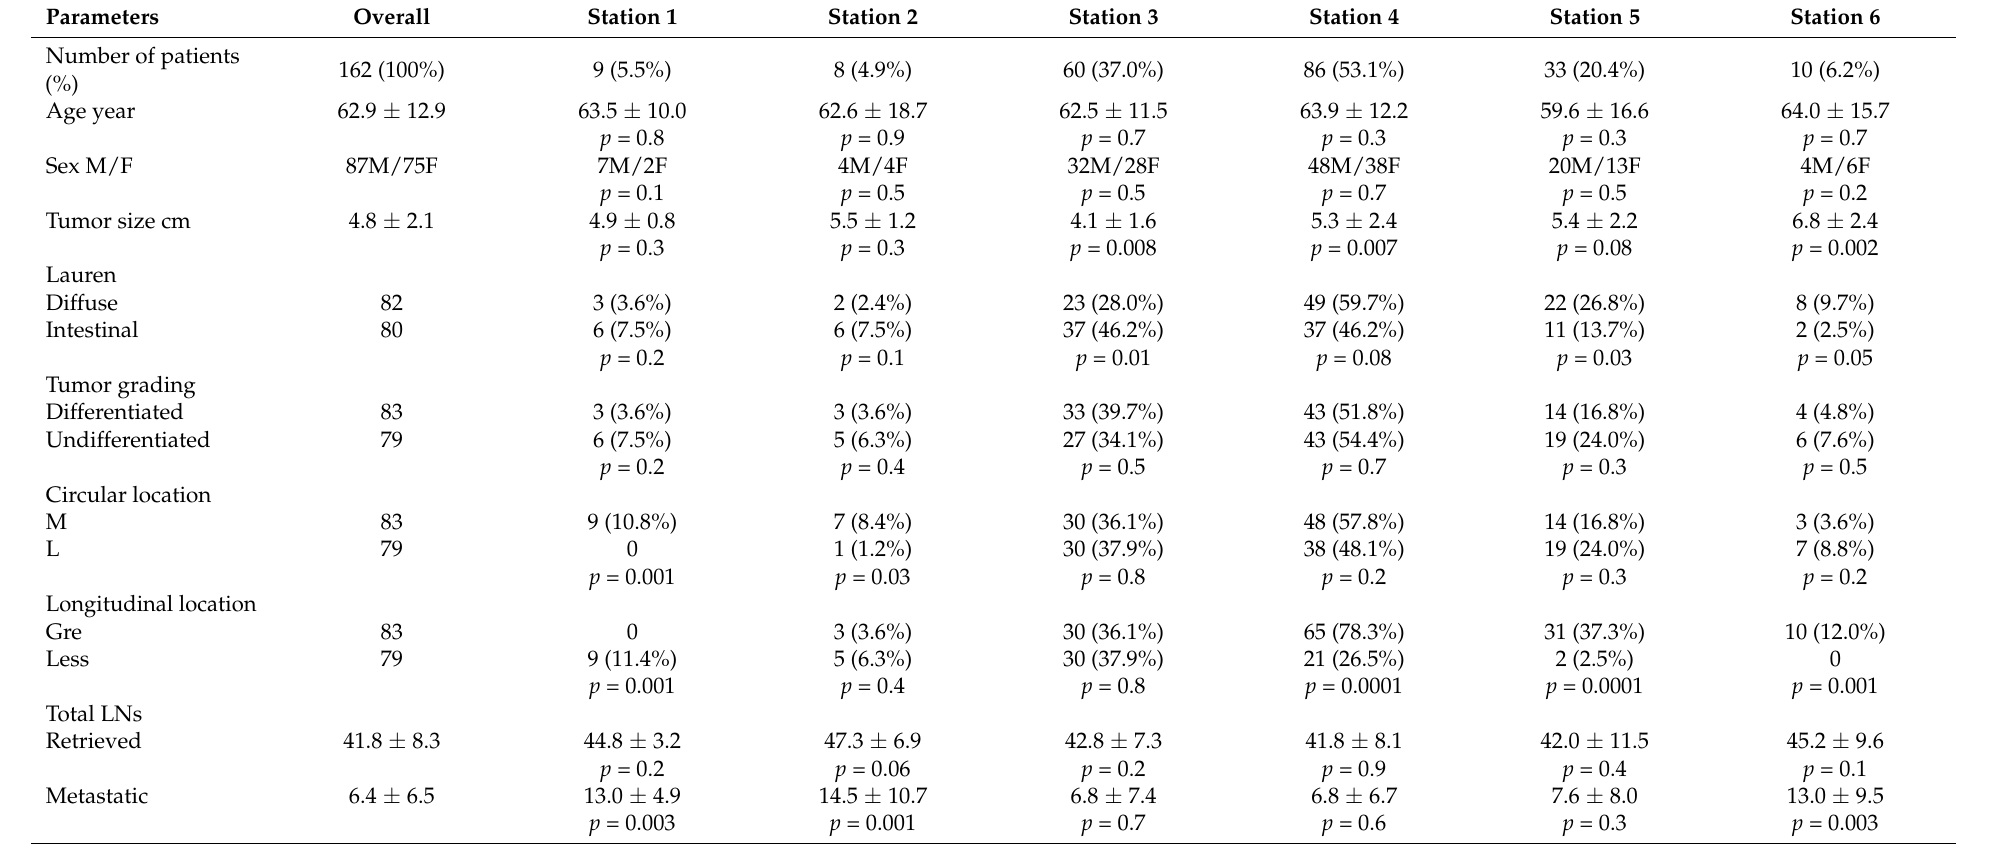
Table 5. Incidence of LN metastasis per perigastric nodal